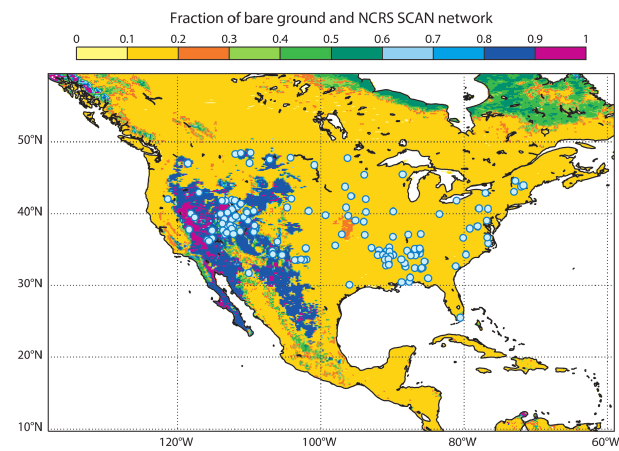
Fig. 1. Location of the different in situ soil moisture stations used in this study (blue circles); the stations belong to the NRCS-SCAN network (United States). Colour scale represents the fraction of bare